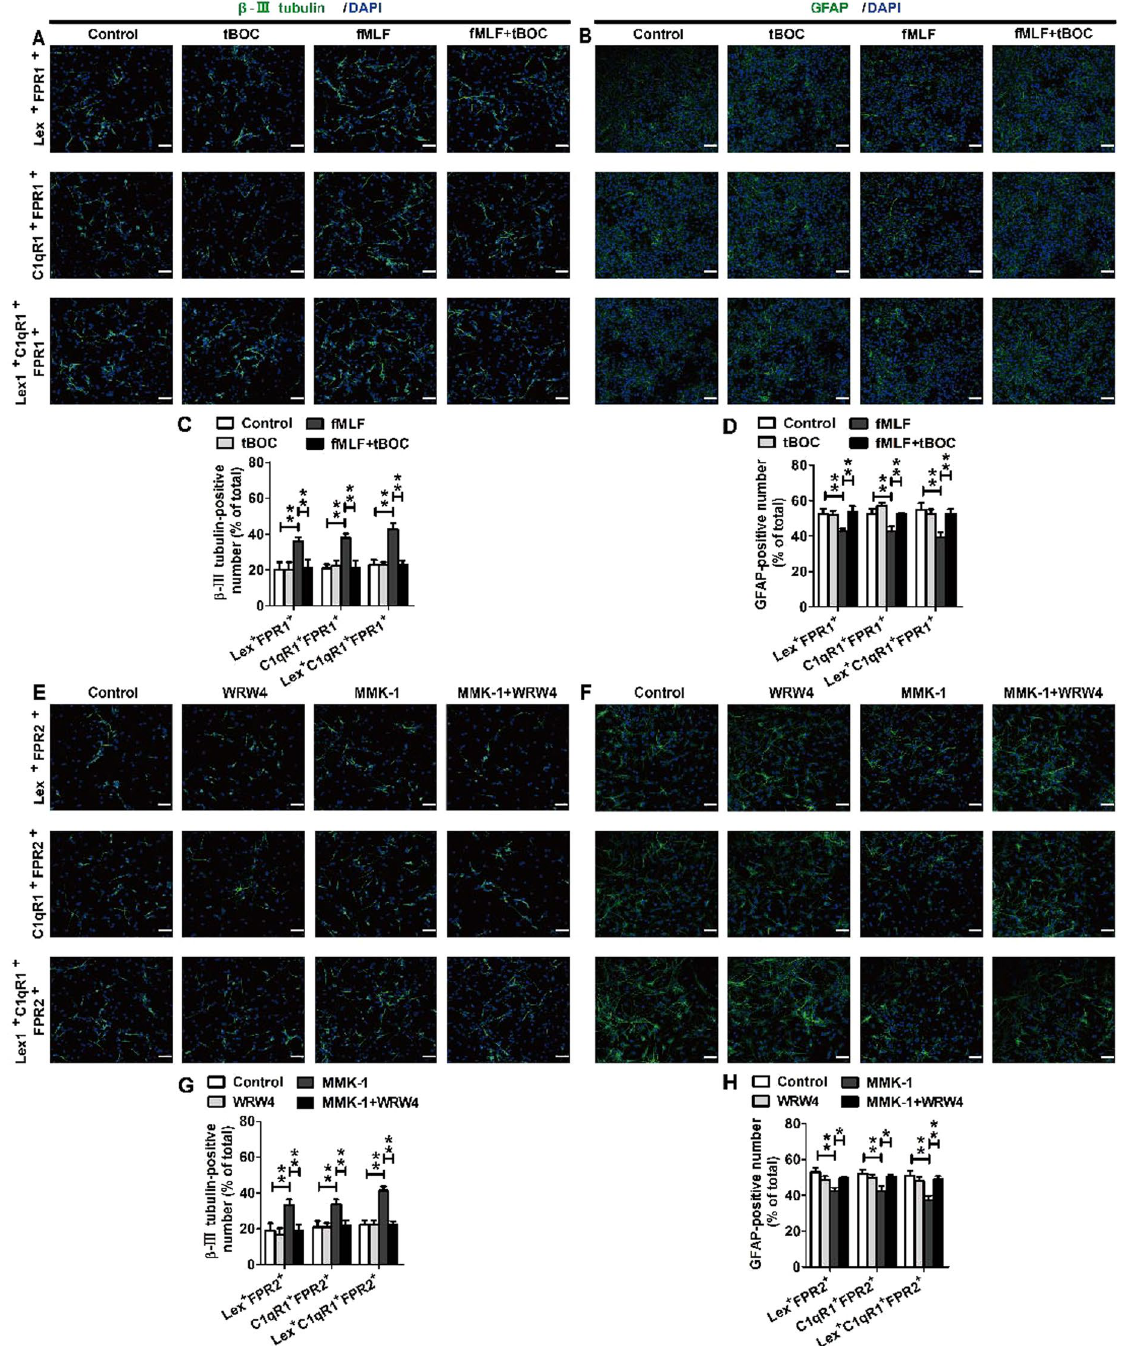
Figure 6. FPRs promoted neuronal differentiation of Lex + FPR + , C1qR1 + FPR + or Lex + C1qR1 + FPR + cells from dissociated neurospheres. ( A–D ) FPR1 promoted neuronal differentiation of Lex + FPR1 + , C1qR1 + FPR1 + or Lex + C1qR1 + FPR1 + cells. Cells were sorted using a Becton Dickinson FACS Aria with markers, including Lex, C1qR1 or FPR1. Each cell population was cultured for 4 days with or without preadministering tBOC for 30 min before administering fMLF, before proceeding to culture with neural differentiation medium. The differentiated cells were then identified by immunocytochemistry using antibodies against β -III tubulin and GFAP. The images in ( A,B ) are representative of several independent experiments, and the graph in ( C,D ) shows the statistical results. ( E–H ) FPR2 promoted neuronal differentiation of Lex + FPR2 + , C1qR1 + FPR2 + or Lex + C1qR1 + FPR2 + cells. Each cell population was cultured for 4 days with or without preadministering WRW4 for 30 min before administering MMK-1, following to culture with neural differentiation medium. The differentiated cells were then identified by immunocytochemistry using antibodies against β -III tubulin and GFAP. The images in ( E,F ) are representative of several independent experiments, and the graph in ( G,H ) shows the statistical results. Data were presented as mean ± SEM; * P < 0.05. N = 6. Scale bar = 20 µ